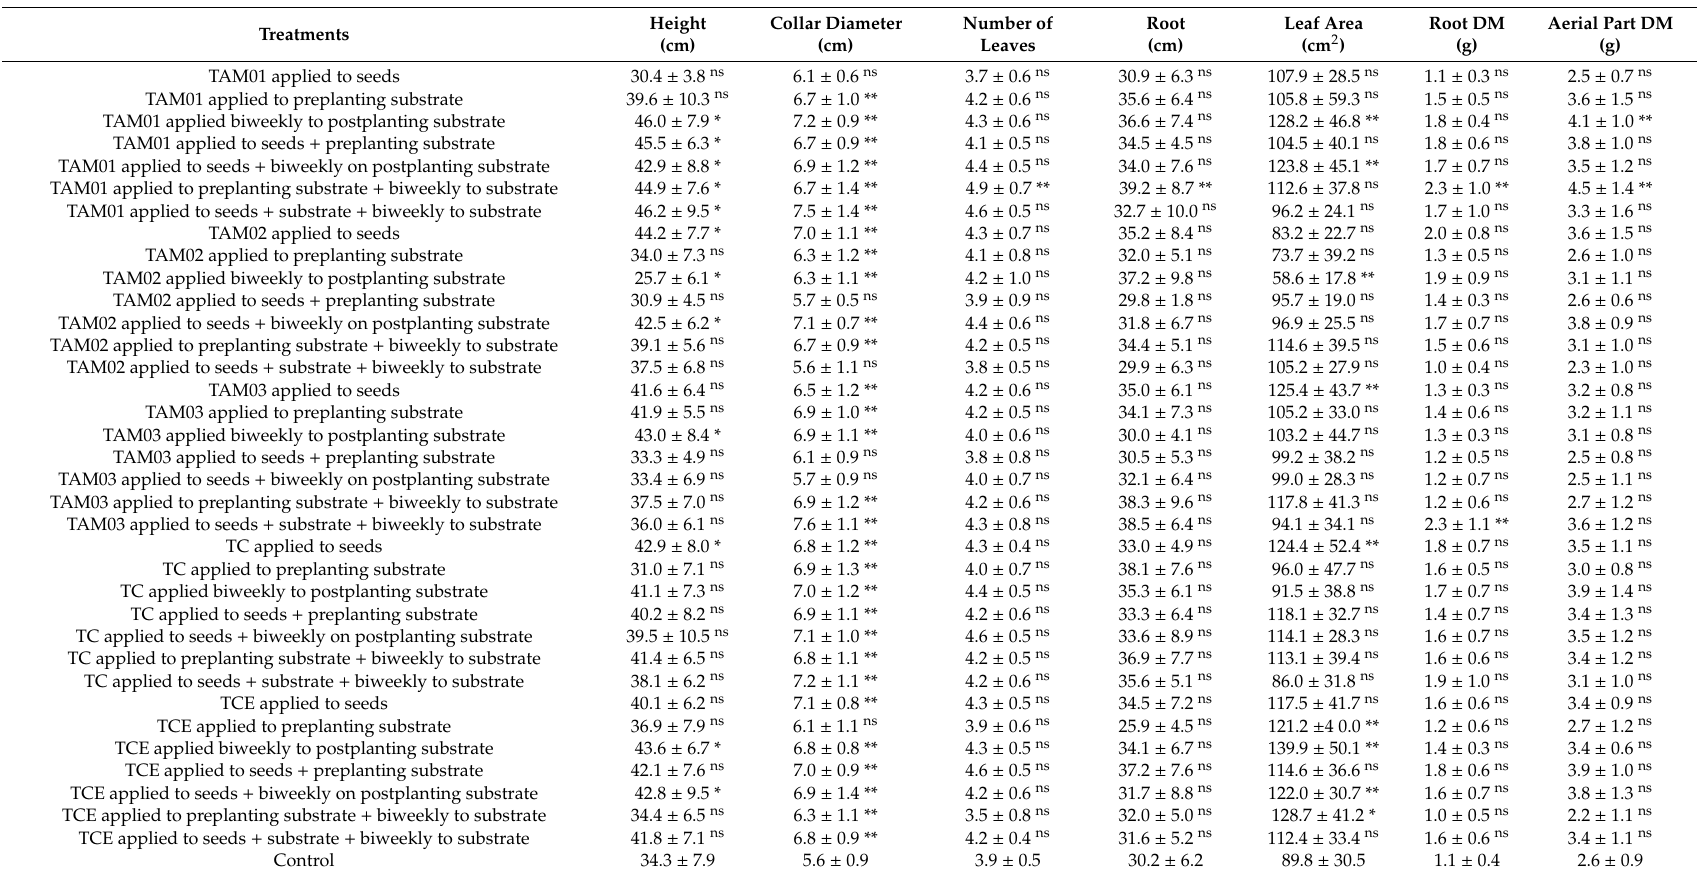
Table 3. Average and standard deviation of height, collar diameter, number of leaves, root length, leaf area, root and aerial part dry mass of Aça í ( Euterpe oleracea ) seedlings submitted to di ff erent modes of application of five Trichoderma spp. isolates at 132 days after planting.